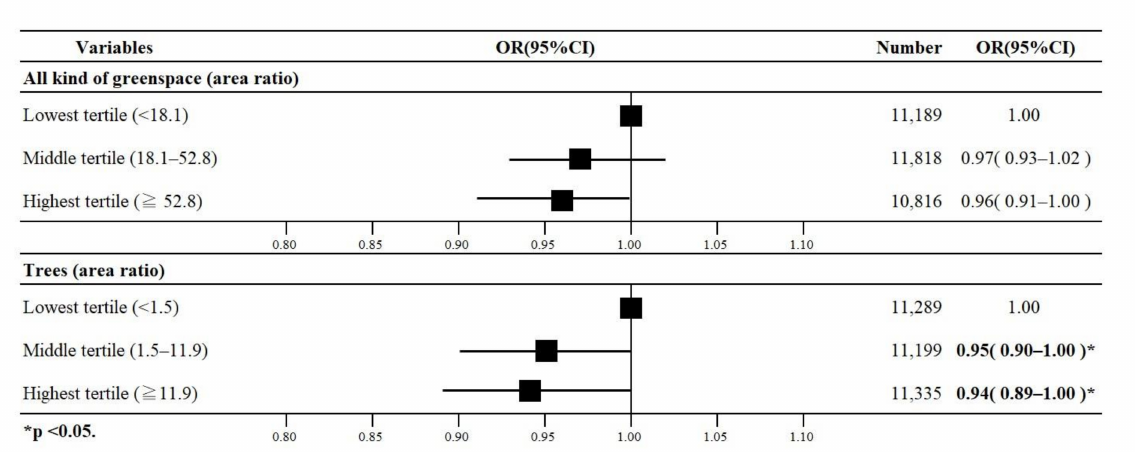
Figure 5. Odds ratios (ORs) with 95% confidence intervals (95% CI) for the association of all kinds of greenspace and trees with depression among older adults in urban areas ( n = 93,055).